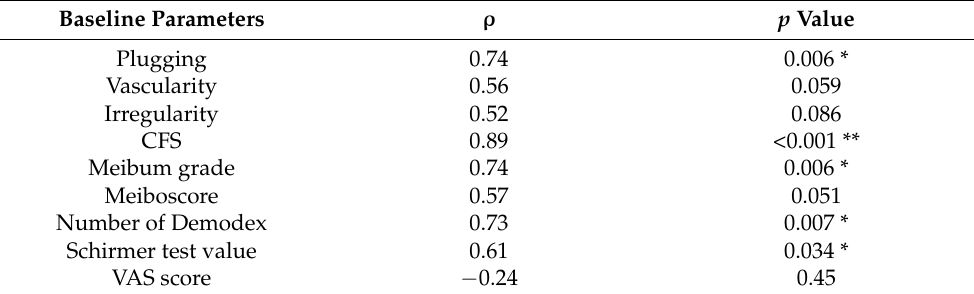
Table 5. Spearman’s correlation coefficient ( ρ ) and p values for the relation between baseline param- eters and the number for treatment in the intense pulsed light (IPL)–meibomian gland expression (MGX) group ( n = 12